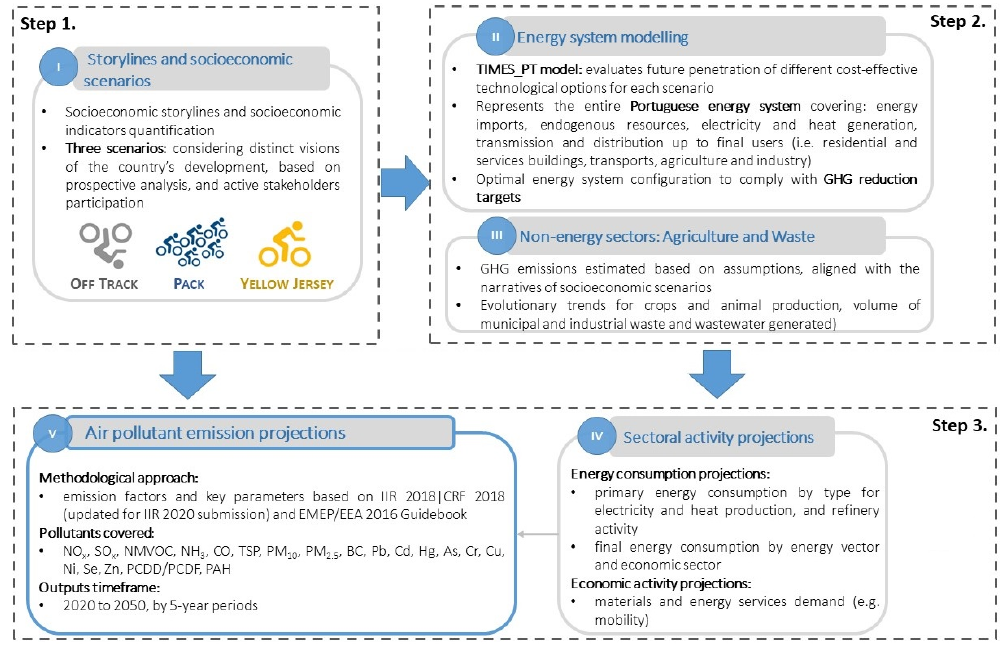
Figure 1. General methodology applied to estimate air pollutant emissions associated to CNR2050.